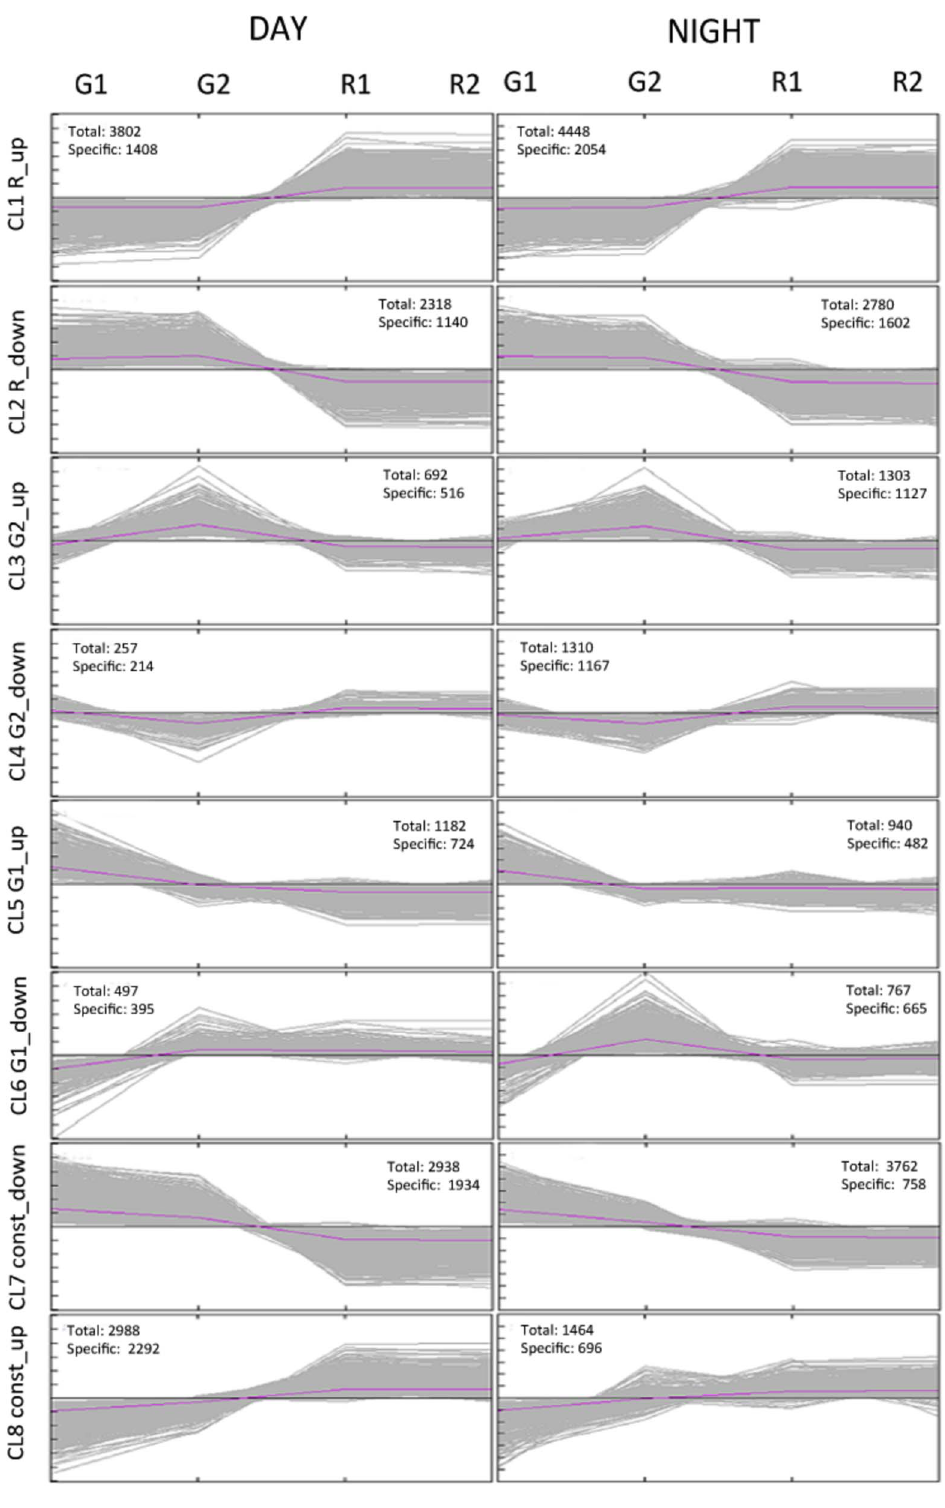
Figure 3. Expression profiles of developmentally regulated genes during the day and night. Clustering was performed using k-means statistics on mean centered RMA normalized expression log 2 values. Numbers of all day respectively night specific transcripts in each cluster are displayed. doi:10.1371/journal.pone.0088844.g003 ripening. Studies on Arabidopsis thaliana RBOHc ( Atrbohc ) mutants which are responsible for localized cell expansion during root-hair indicated that ROIs activate hyper-polarization Ca 2 + channels formation [52]. The induction of a calcium-transporting ATPase